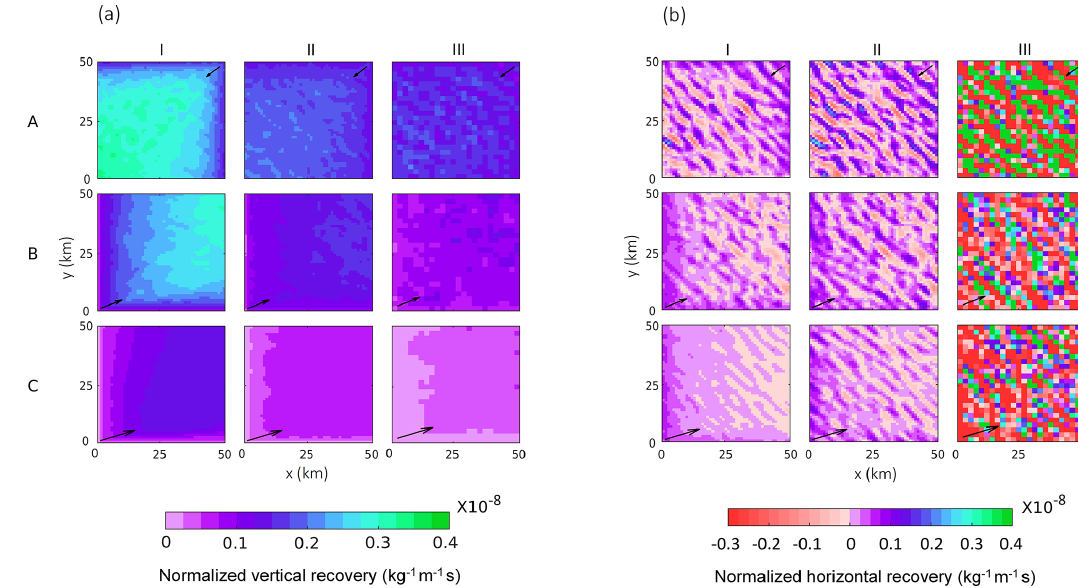
Figure 11. Same as Fig. 6 but with horizontal TKE advection turned